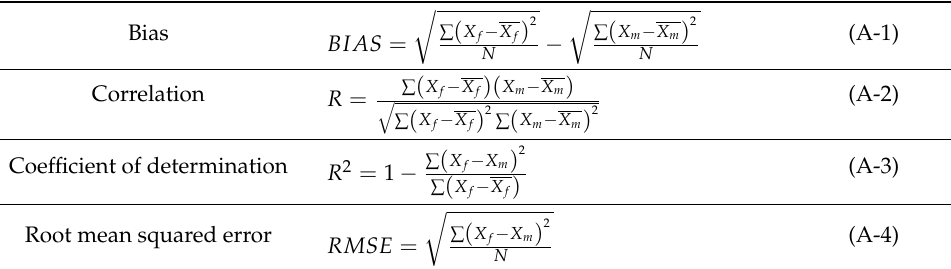
Table 3. Model skill assessments.